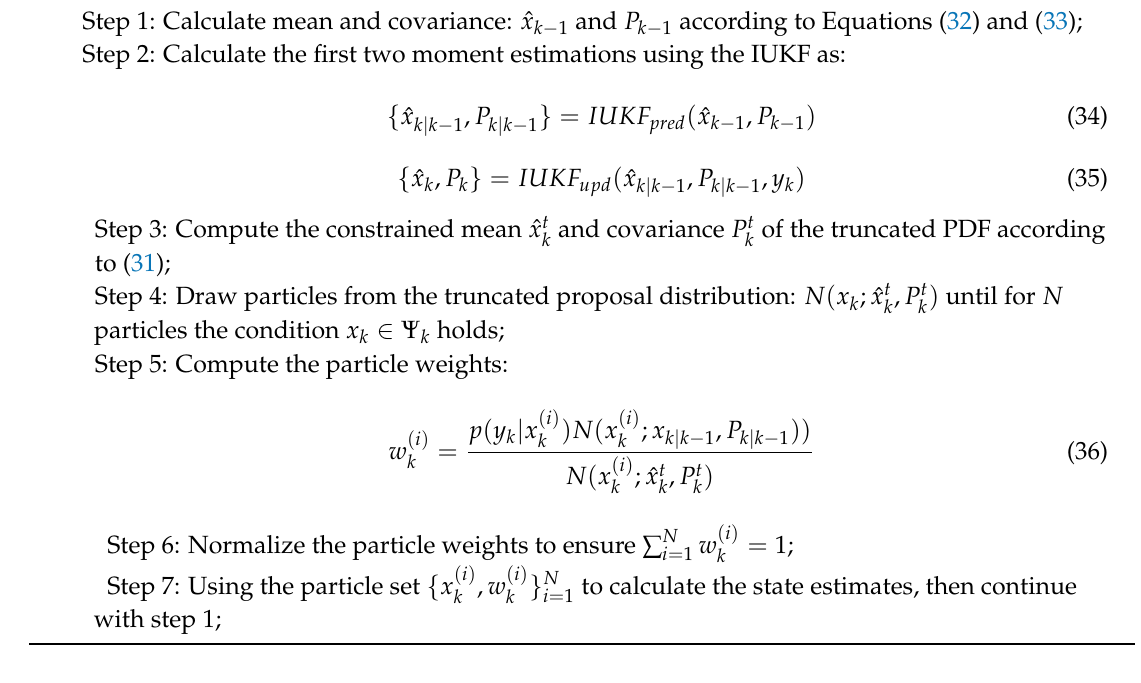
Algorithm 1: Iterative Truncated Unscented Particle